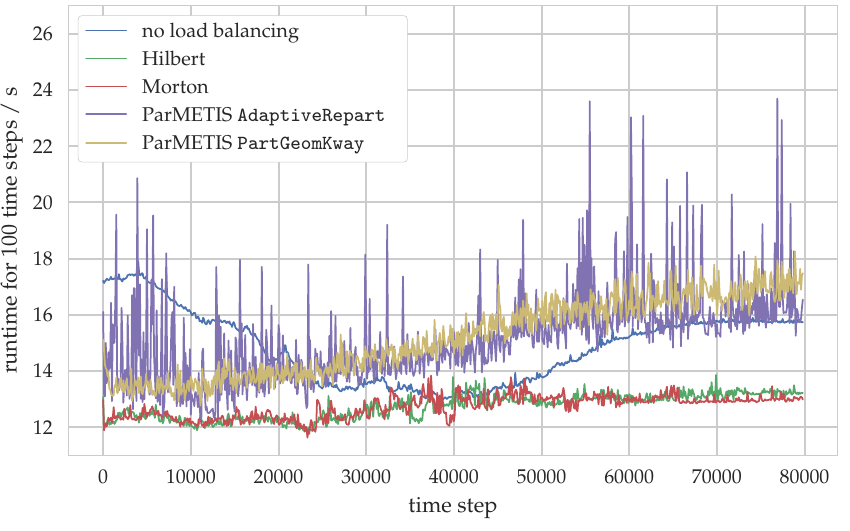
Figure 10. Runtime per 100 time steps in seconds over the time steps for simulation shown in Figure 9. Four load distribution variants using the load estimator from Section 3 are shown together with the case where no load balancing is